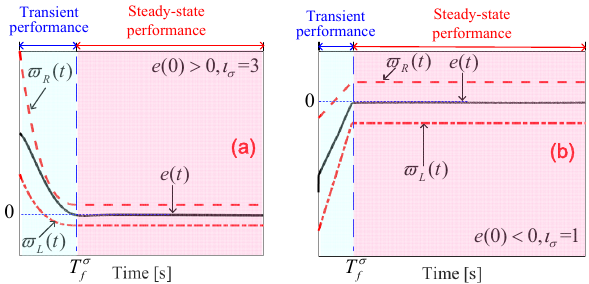
Figure 1. Prescribed performance boundary (3); ( a ) e ( t ) > 0; ( b ) e ( 0 ) <